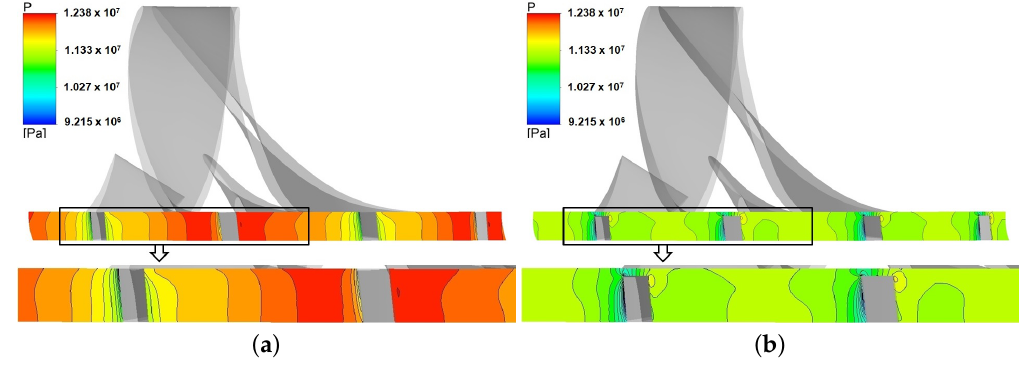
Figure 8. Circumferential pressure contour at the trailing edge for mass flow rate of 4 kg/s. ( a ) Impeller alone. ( b ) Impeller with vaneless.